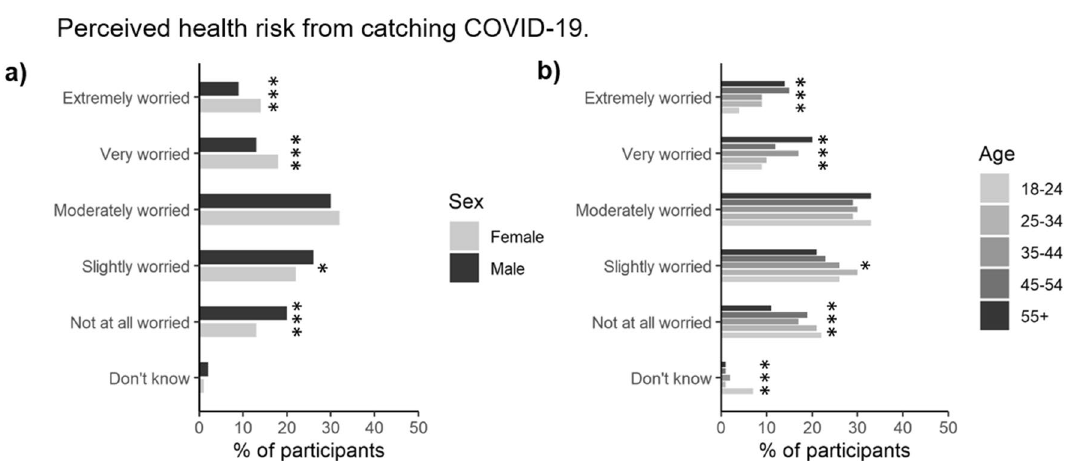
Figure 3. Proportion of participants stratified by either ( a ) gender, or ( b ) age ( n = 2103). *, **, and *** represent significant differences between the gender or age categories for a particular symptom at the P < 0.05, P < 0.01 or P < 0.001 level,